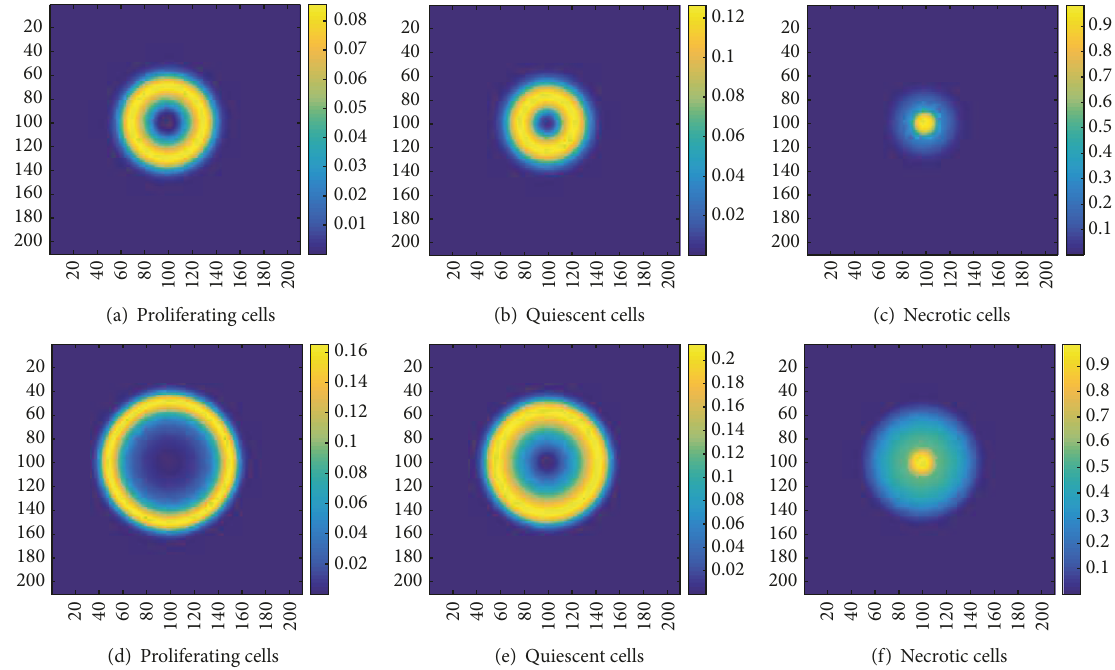
Figure 13: Heat map of cell densities at different proliferating rates: the top row corresponds to the standard rate at 𝛽 = 0.4 ; the bottom row corresponds to a higher proliferating rate at 𝛽 = 0.6 .